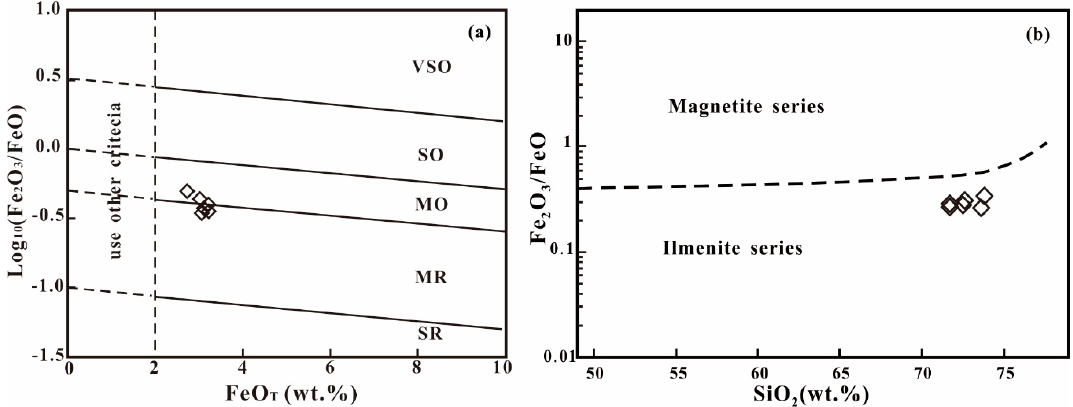
Figure 12. Redox classification scheme for the MG from Wulandele Mo deposit ( a after [44]; b after [45]). FeO T refers to the total Fe in the sample reported as FeO (total). VSO—very strongly oxidized, SO—strongly oxidized, MO—moderately oxidized, MR—moderately reduced, SR—strongly